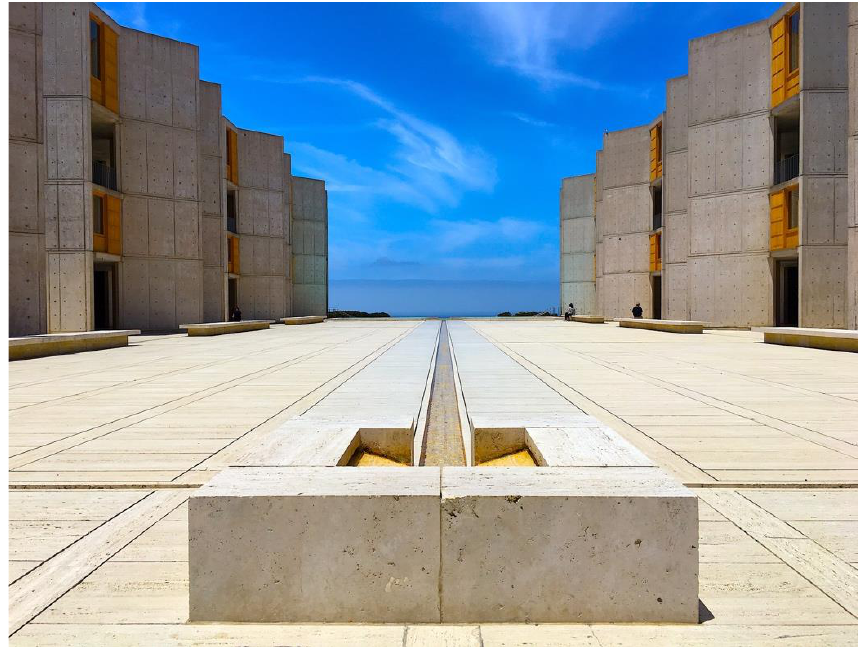
Figure 1. The Salk Institute, California.